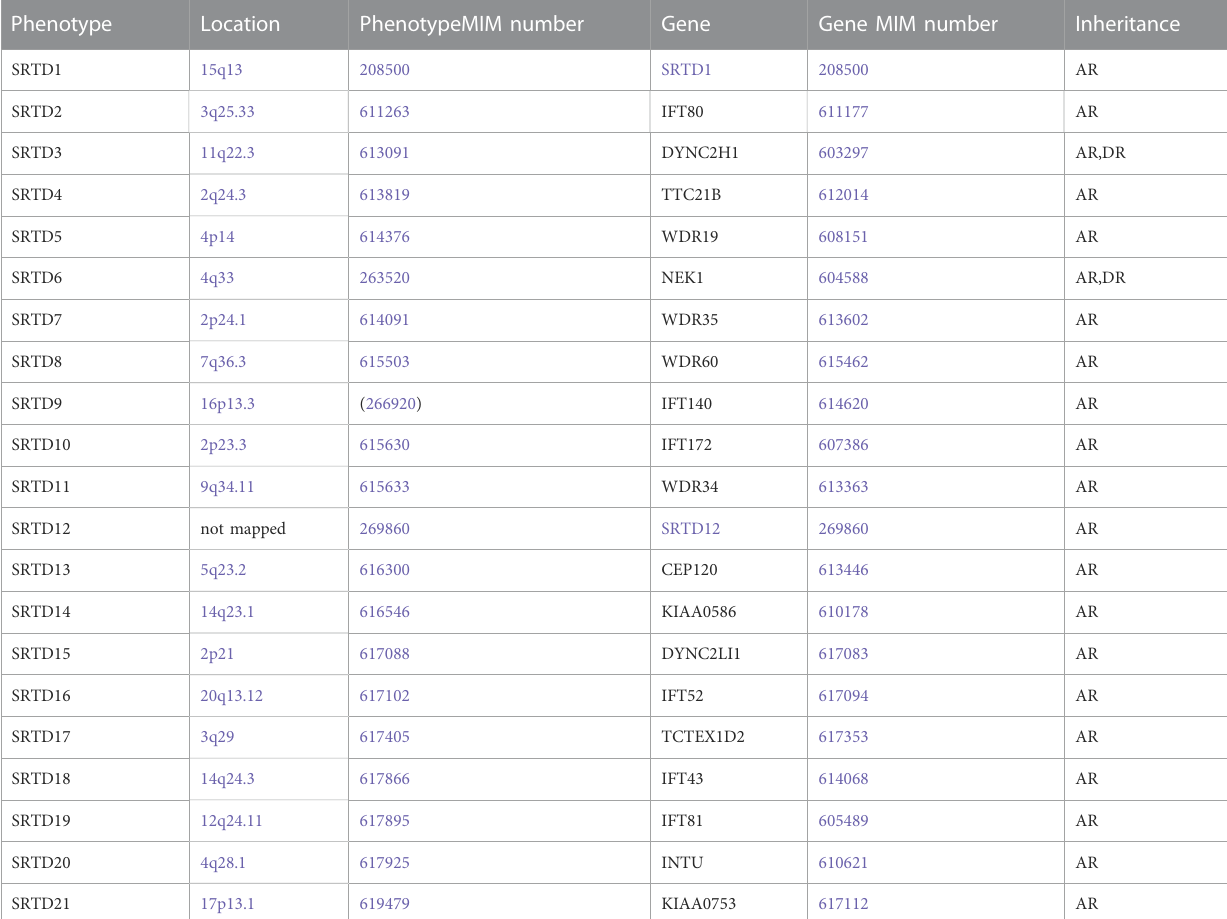
TABLE 1 SRTD are classi fi ed into the categories of